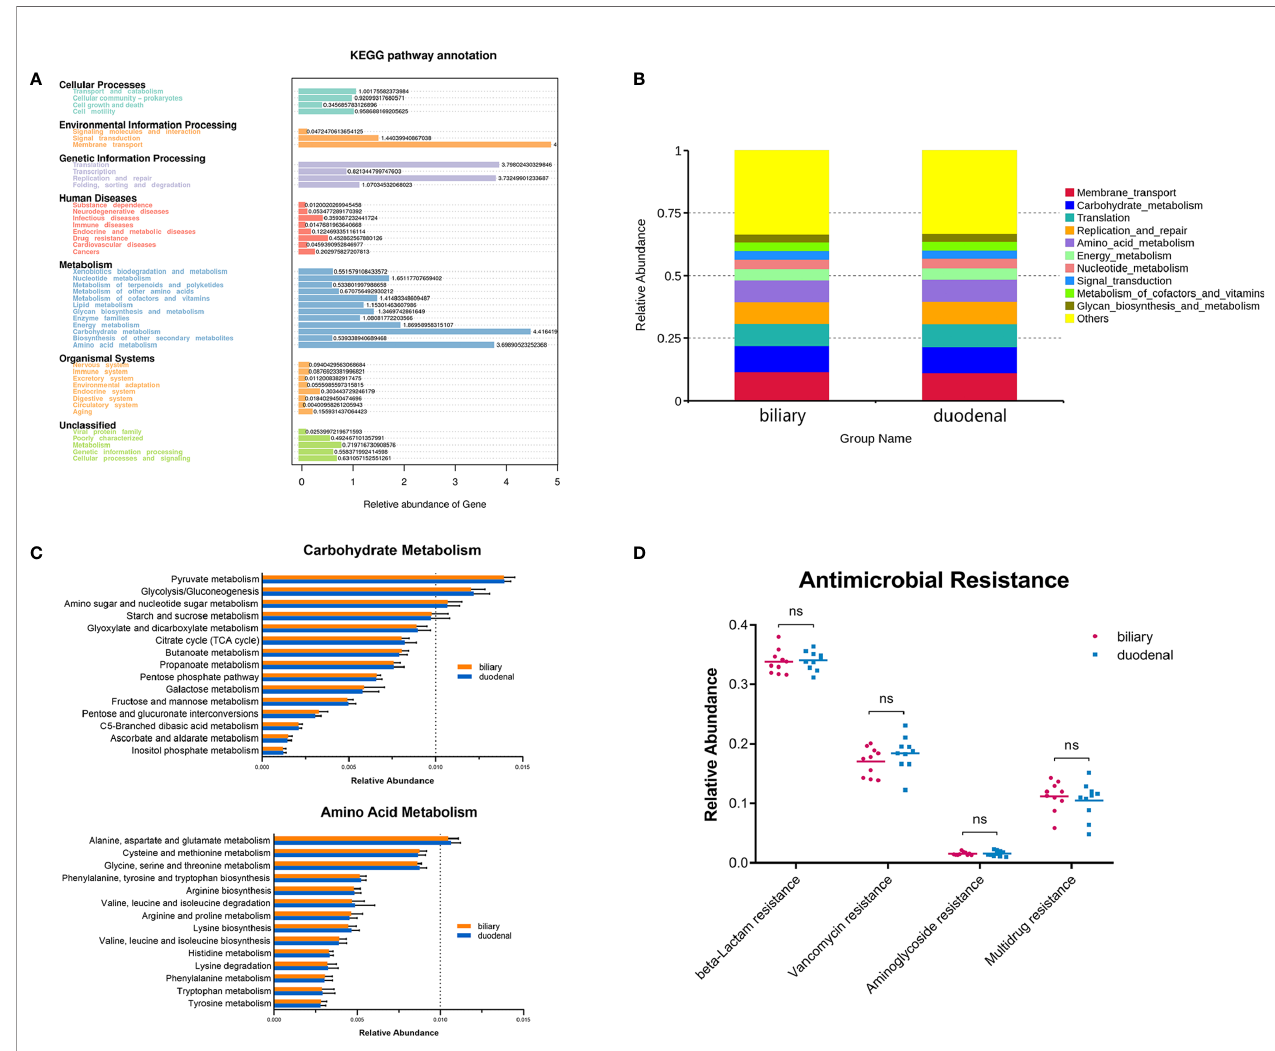
FIGURE 3 | Prediction offunctional capacities of biliary and duodenal microbiota of patients with choledocholithiasis. (A) KEGG pathway annotation and relative abundance of genes. (B) Predicted functional pro fi les between biliary and duodenal microbiota. (C) Relative abundance of the subordinate pathways of carbohydrate metabolism and amino acid metabolism. (D) Comparison of gene sets associated with antimicrobial resistance between biliary and duodenal microbiota. ns, not signi fi